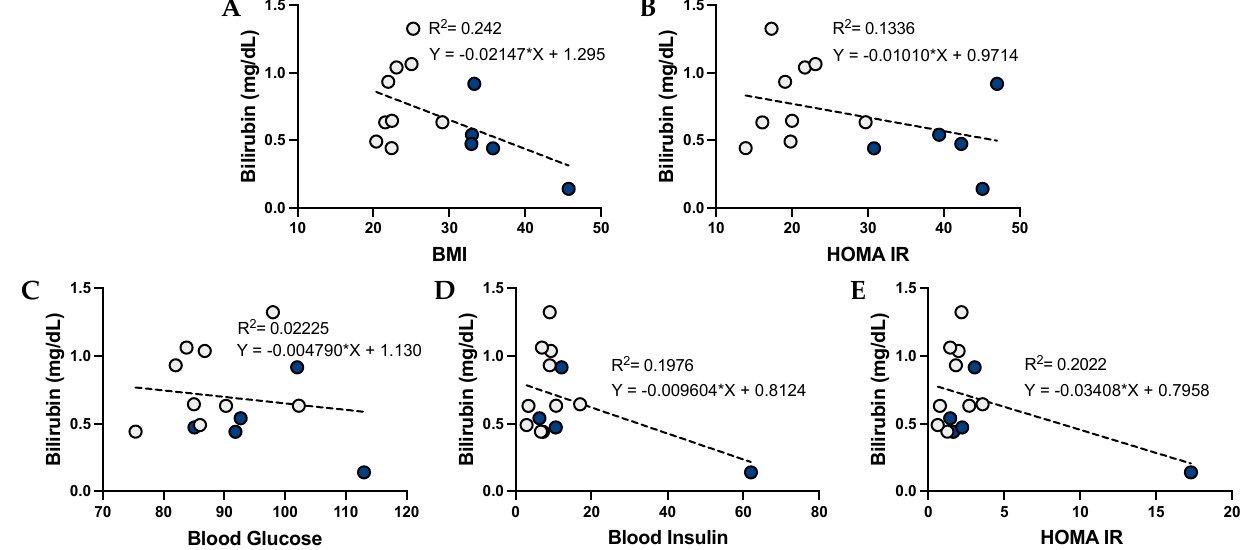
Figure 7. Bilirubin levels and correlations with metabolic phenotypes in men . Comparisons of metabolic phenotypes in men with plasma bilirubin levels for ( A ) BMI, ( B ) body fat percentage, ( C ) blood glucose, ( D ) blood insulin, and ( E ) HOMA IR. The data were plotted as dot plots, linear regression was calculated, and the slope of the line was used to determine the relationship and the robustness of the data. Blue circles are for obese men, and gray circles are for their lean counterparts.